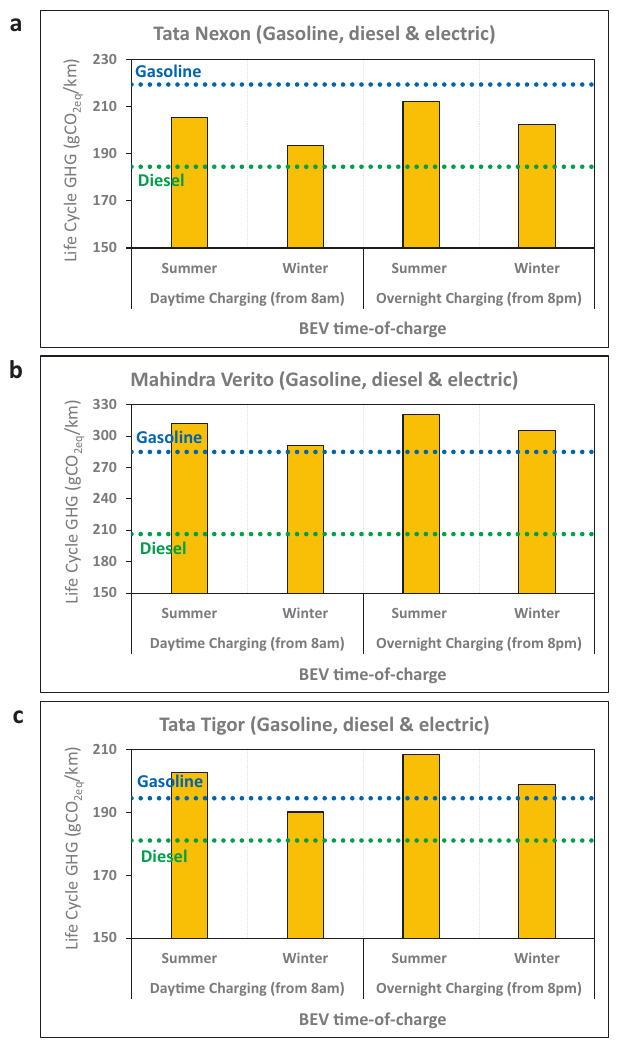
Fig. 2 Seasonal and diurnal variations. Effects of battery recharging time on the life cycle GHG emissions of battery-electric vehicles (BEV) based on the 24 h grid fl uctuations of a typical day in winter and summer in India in 2018/2019 (refer to Supplementary Fig. 4 for the hourly grid fl uctuations in India and the impacts on the carbon intensity of electricity). Daytime charging starts at 8 am, while overnight charging starts at 8 pm. Charging duration is estimated based on the BEV ’ s battery size and the use of a typical 2.5 kW charger 102 , with a total vehicle lifetime distance of 200,000km for ( a ) Tata Nexon, ( b ) Mahindra Verito, and ( c ) Tata